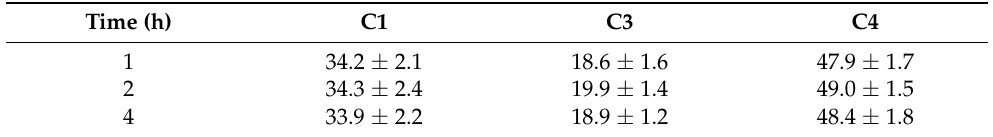
Table 7. Efflux (%) values of the 99m Tc complexes in LNCaP cells as a function of incubation time. Values are expressed as means ± SD, n = 3.